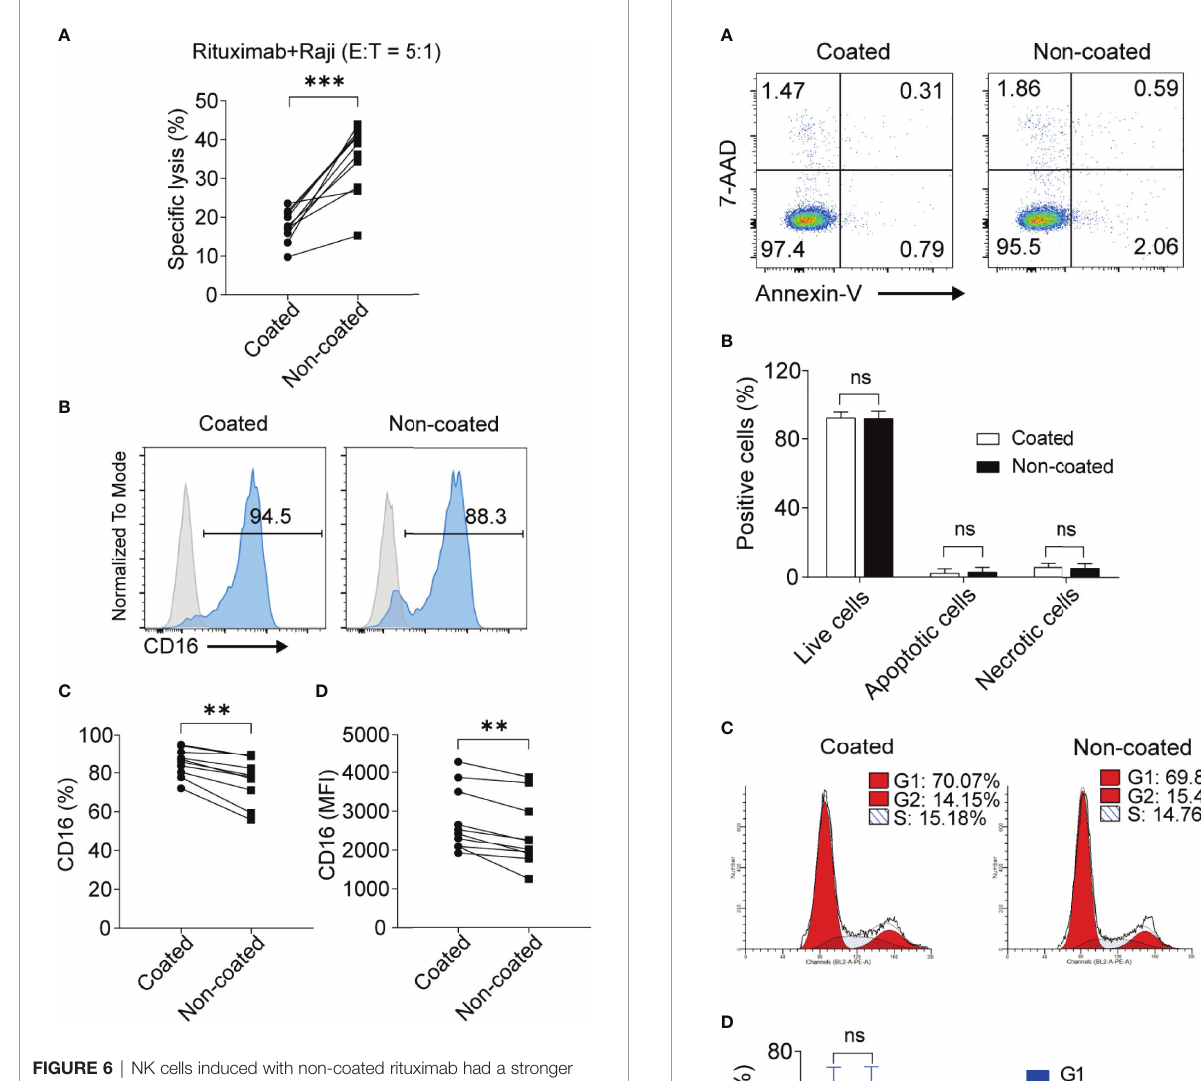
FIGURE 6 | NK cells induced with non-coated rituximab had a stronger ADCC effect. NK cells were activated by coated and non-coated rituximab for